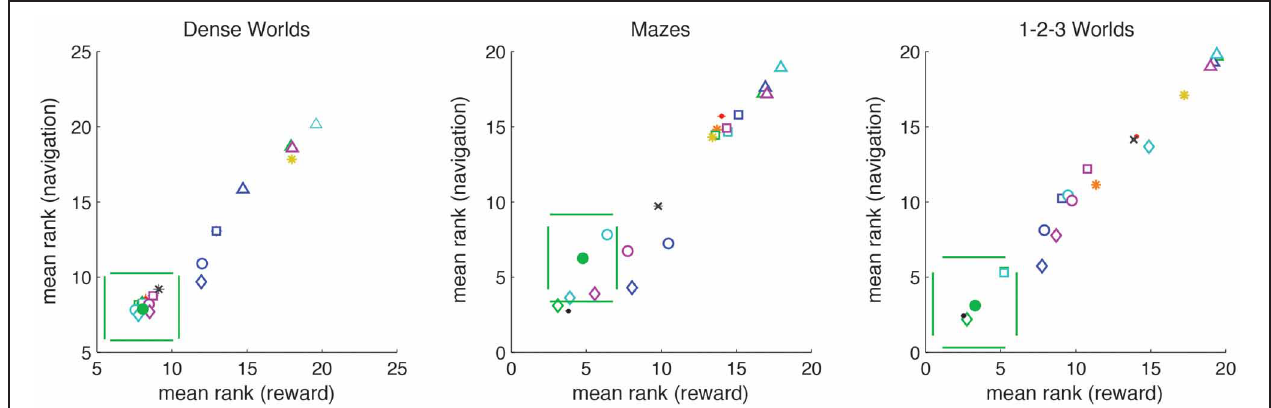
FIGURE 8 | Demonstration of generalized utility. For each world ( n = 200), explorative strategies are ranked for average performance on the navigational tasks (averaged across N start states and N target states) and the reward tasks (averaged across N start states and 10 randomly generated reward distributions). The average ranks are plotted with standard deviations. PIG(VI) is depicted as a filled green circle. Strategies lying outside the pair of horizontal green lines differ significantly from PIG(VI) in navigational performance. Strategies lying outside the pair of